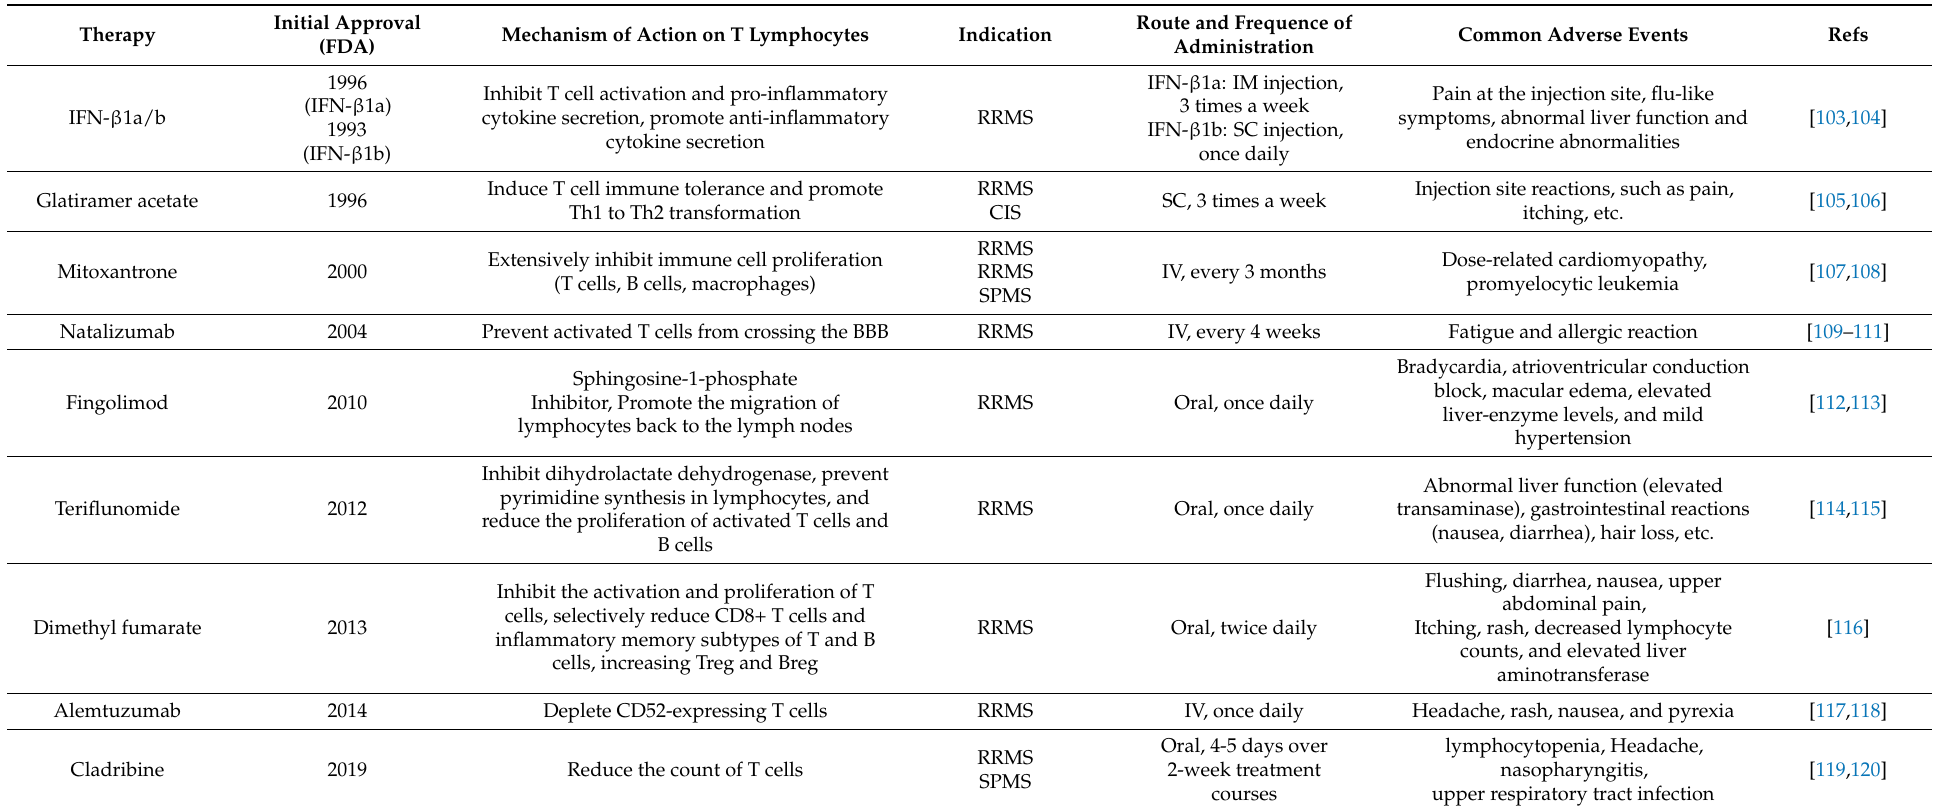
Table 2. Disease-modifying drugs for multiple sclerosis that are approved to act on T